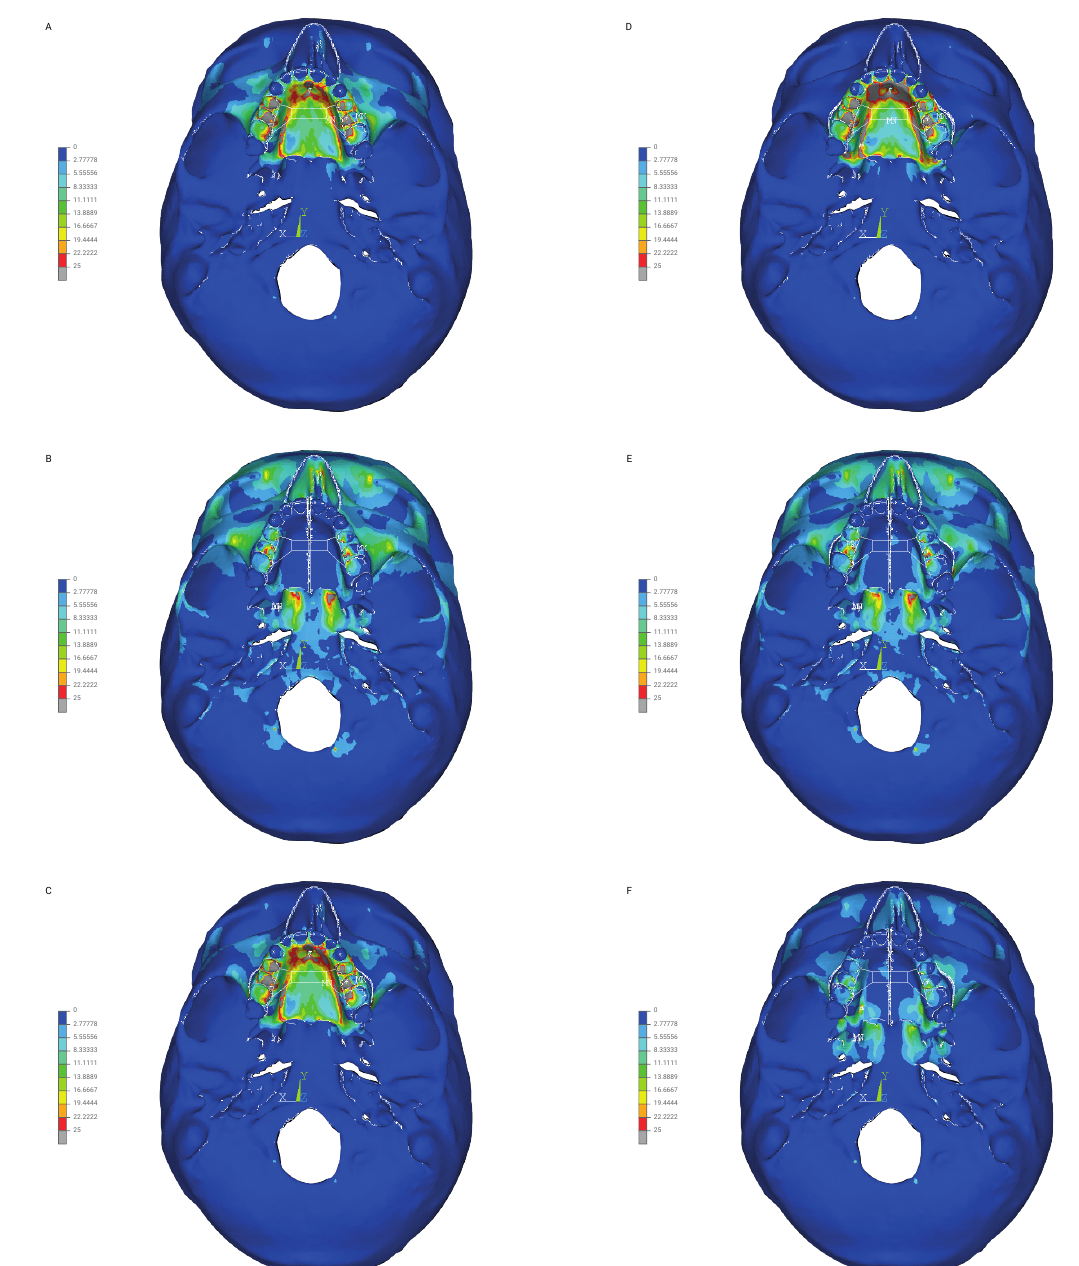
Figure 6. ( A – F ). The finite element model showing according to Huber stress distribution over craniofacial skeleton—bottom view (scale 0–25 MPa) caused by palatal expansion using five di ff erent surgical procedures and without osteotomy: ( A ) without osteotomy; ( B ) sagittal osteotomy; ( C ) transversal osteotomy modo Le Fort I without PMJ separation; ( D ) transversal osteotomy modo Le Fort I with PMJ separation; ( E ) sagittal osteotomy with transversal osteotomy modo Le Fort I without PMJ separation; ( F ) the model used for finite element analysis—sagittal osteotomy with transversal osteotomy modo Le Fort I with PMJ separation. PMJ—pterygomaxillary